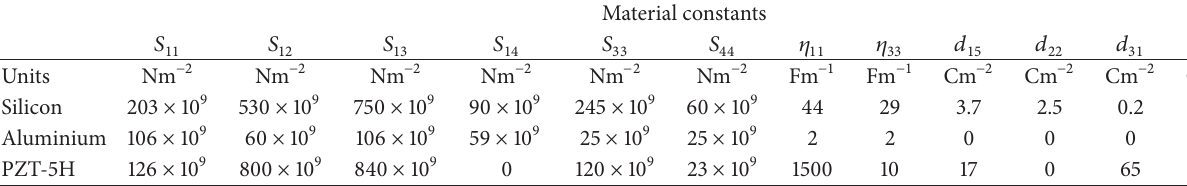
Table 3: Material constants for the materials used in design.